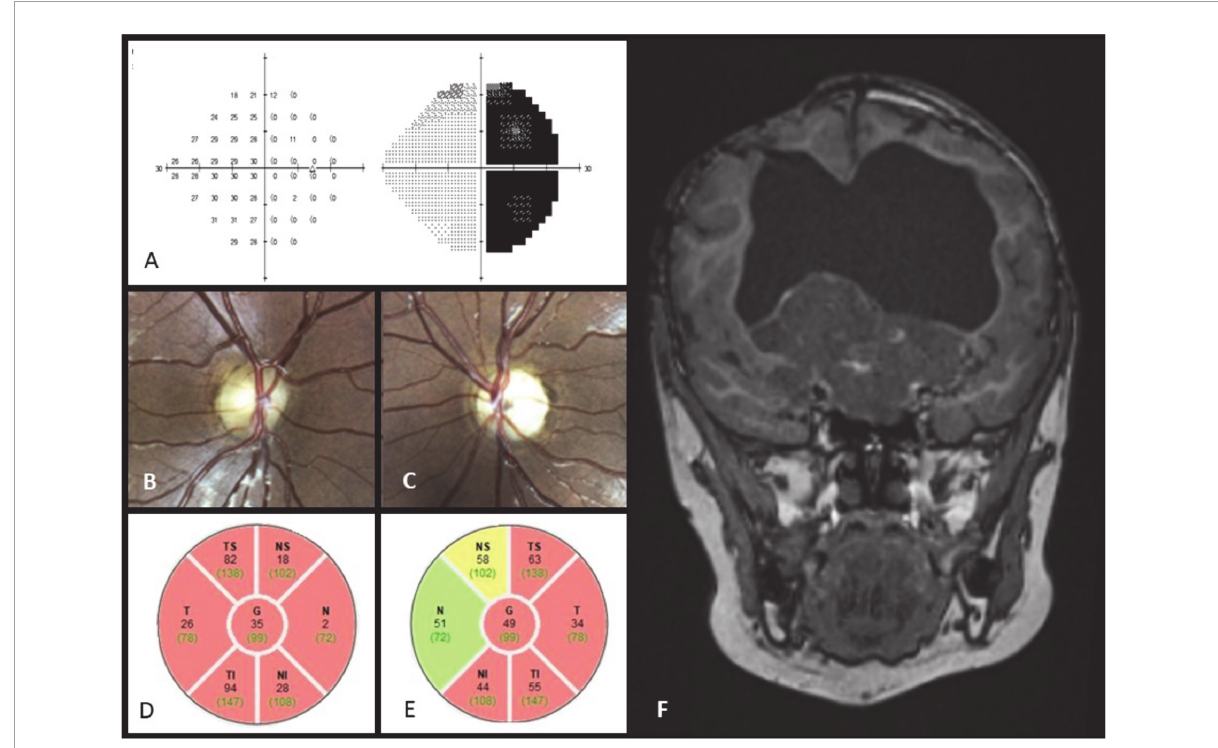
FIGURE6 Case 6. Automated perimetry demonstrating a temporal hemianopia in the right eye (A) . Fundus color photograph shows bow tie atrophy of the right optic disc (B) and diffuse atrophy of the left optic disc (C). OCT scan showing bilateral diffuse RNFL thinning, which is more profound in the nasal and temporal quadrants of the right optic disc (D,E) . MRI T1 post contrast coronal scan showing massive suprasellar enhancing lesion and severe hydrocephalus (F)